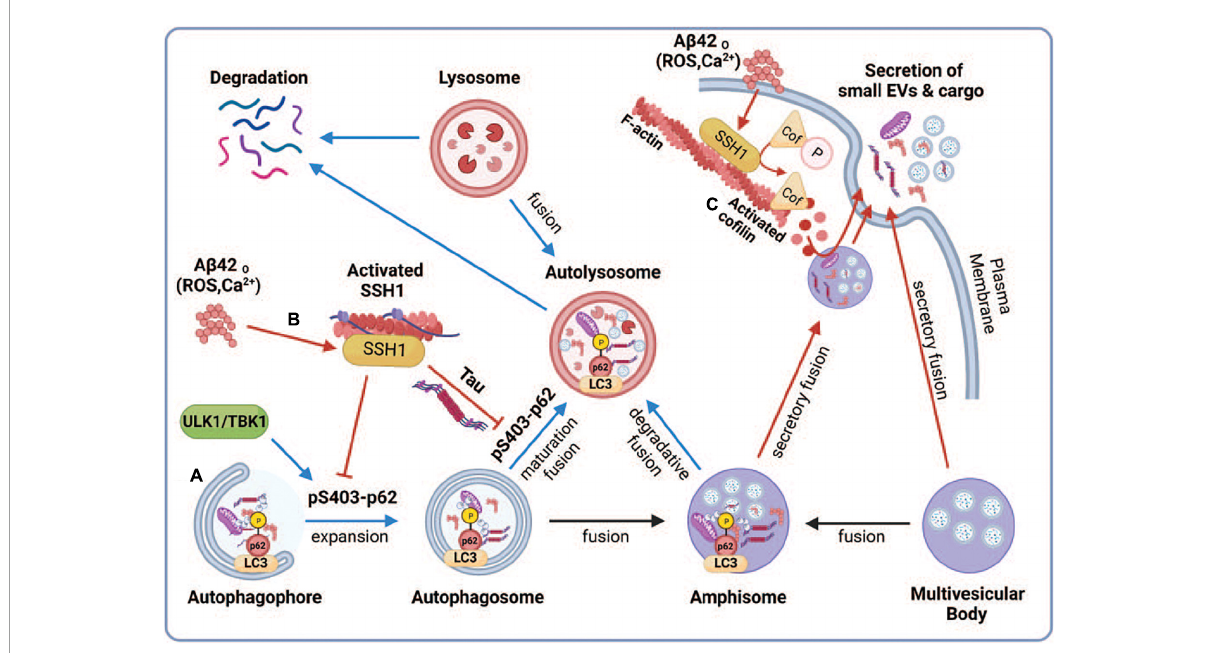
FIGURE6 Proposed model depicting the regulation of small EV secretion by p62-mediated autophagy and cofilin-mediated actin dynamics through the SSH1 pathway. Note that blue lines/arrows favor lysosomal degradation, whereas red lines/arrows favor secretory clearance. (A) Accumulation of misfolded proteins or dysfunctional mitochondria activates autophagy through ULK1 and TBK1, which phosphorylate p62 at Ser403, resulting in p62 binding to ubiquitinated cargo and activation of LC3 to drive autophagosome maturation. This promotes autophagy flux and fusion of autophagosomes and amphisomes with lysosomes, resulting in the degradation of ubiquitinated cargo together with intraluminal vesicles from amphisomes, thereby reducing small EV secretion. (B) Oxidative stress (ROS) or calcium elevation induced by A β oligomers or otherwise activates SSH1, which dephosphorylates p62 at pSer403 and inhibits p62 autophagy flux. Dephosphorylated p62 is less able to bind ubiquitinated cargo and activate LC3, which slows autophagy flux and fusion of autophagosomes and amphisomes with lysosomes. This process diverts amphisomes toward the secretory fusion pathway and increases small EV secretion. Like SSH1, inhibition of p62 autophagy flux by misfolded tau (Fang et al., 2021) also likely contributes to increased small EV secretion. (C) Actin filaments serve to recruit vesicles and create a diffusion barrier for vesicles to gain access to the plasma membrane. SSH1 activation by ROS or calcium also activates cofilin, which severs and depolymerizes the F-actin network near the plasma membrane. This process allows large secretory amphisomes to access membrane docking sites, facilitating small EV secretion. This illustration was generated at